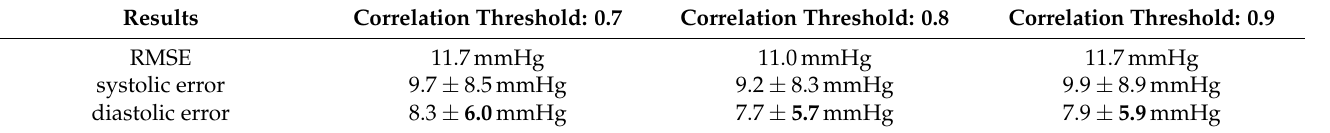
Table 6. Results of applying the best trained model per correlation threshold on the test set.